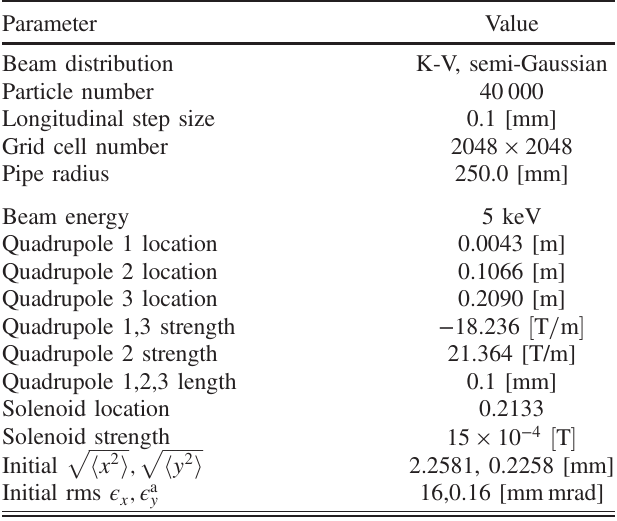
TABLE I. PIC code simulation and FTR lattice